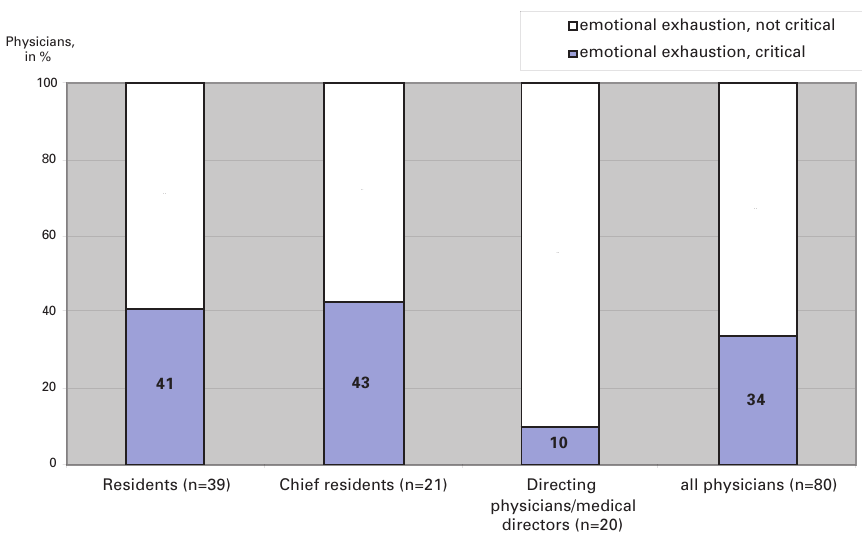
Strains experienced by the different groups of physicians. Note: critical values: persons with stanine values of 7, 8, or